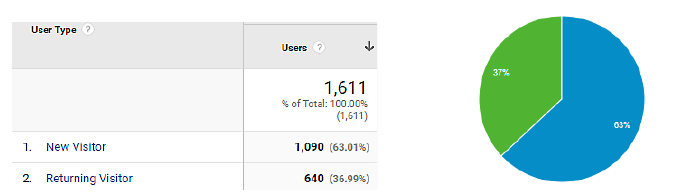
Figure 3. New versus returning visitors (source: created by authors)